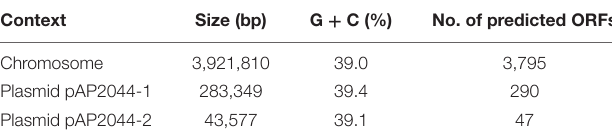
TABLE 2 | Genome characteristics of Acinetobacter pittii strain